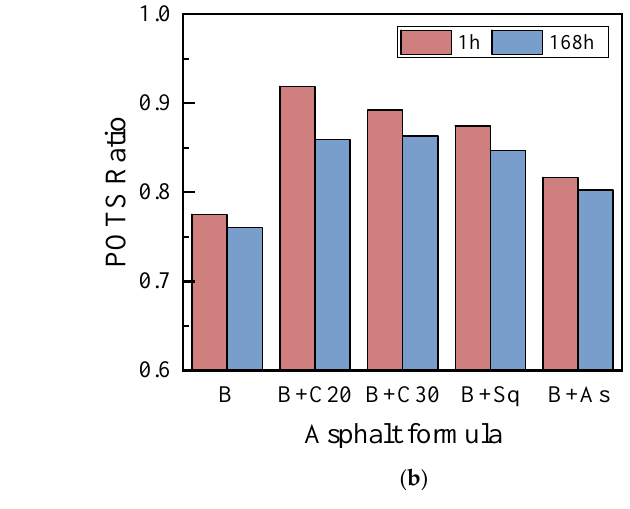
Figure 8. POTS ratio. ( a ) Asphalt A. ( b ) Asphalt B.